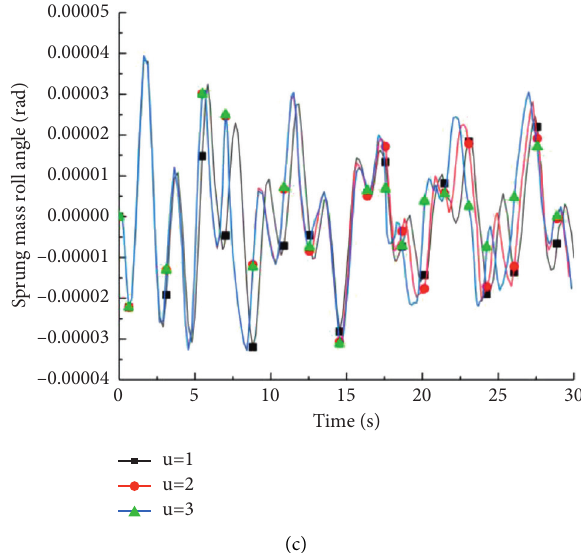
Figure 13: Simulation results of different speeds. (a) Slip angle of the center of mass of the high-clearance sprayer; (b) yaw angular velocity of the sprayer; (c) roll angle of sprung mass of the sprayer.